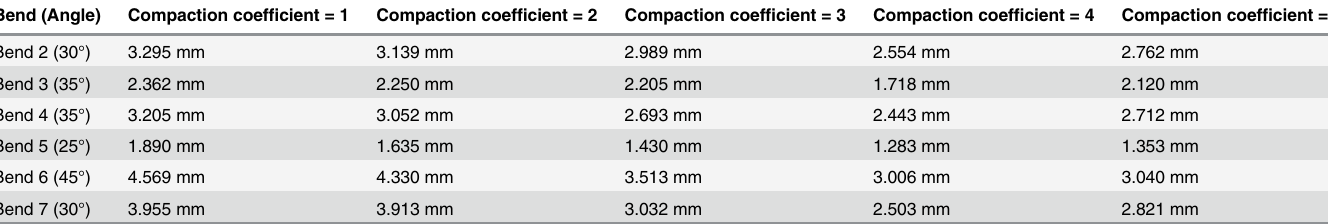
Table 17. Comparison of lateral displacements of bends (25° – 45°) with different Compaction coef fi cients.